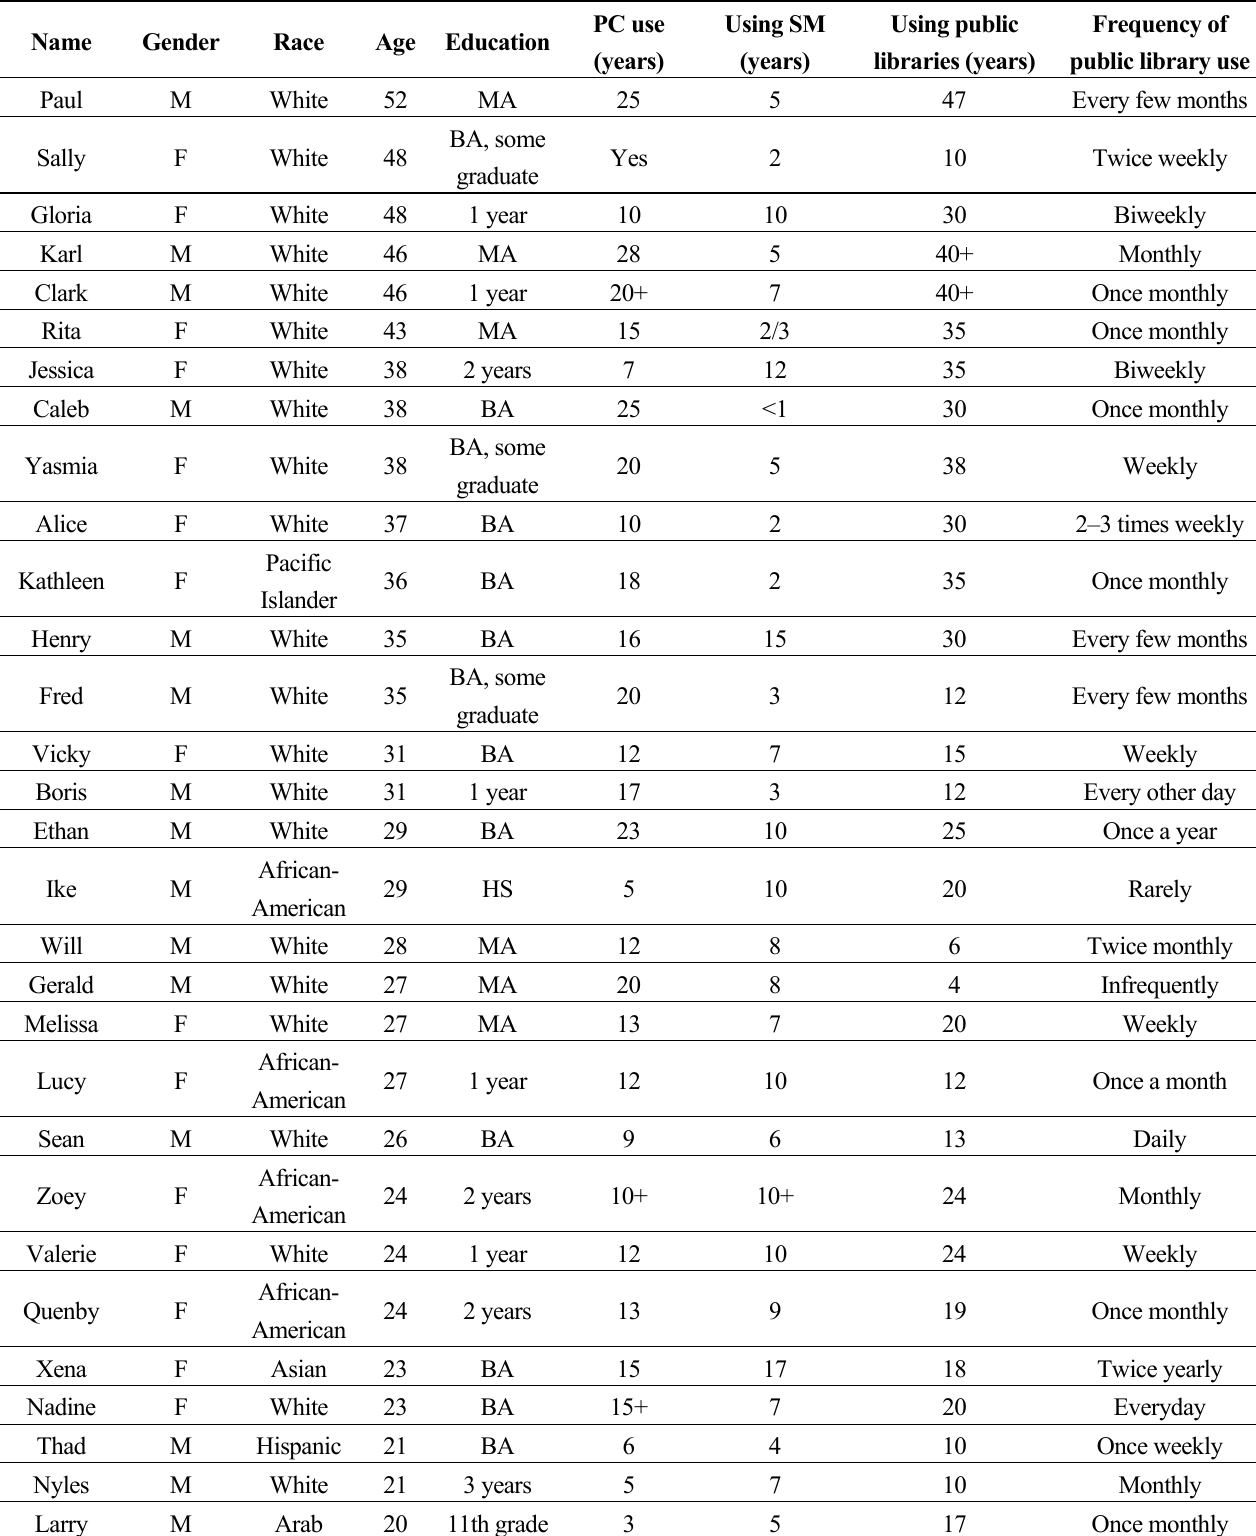
Table 1. Characteristics of participants: public library